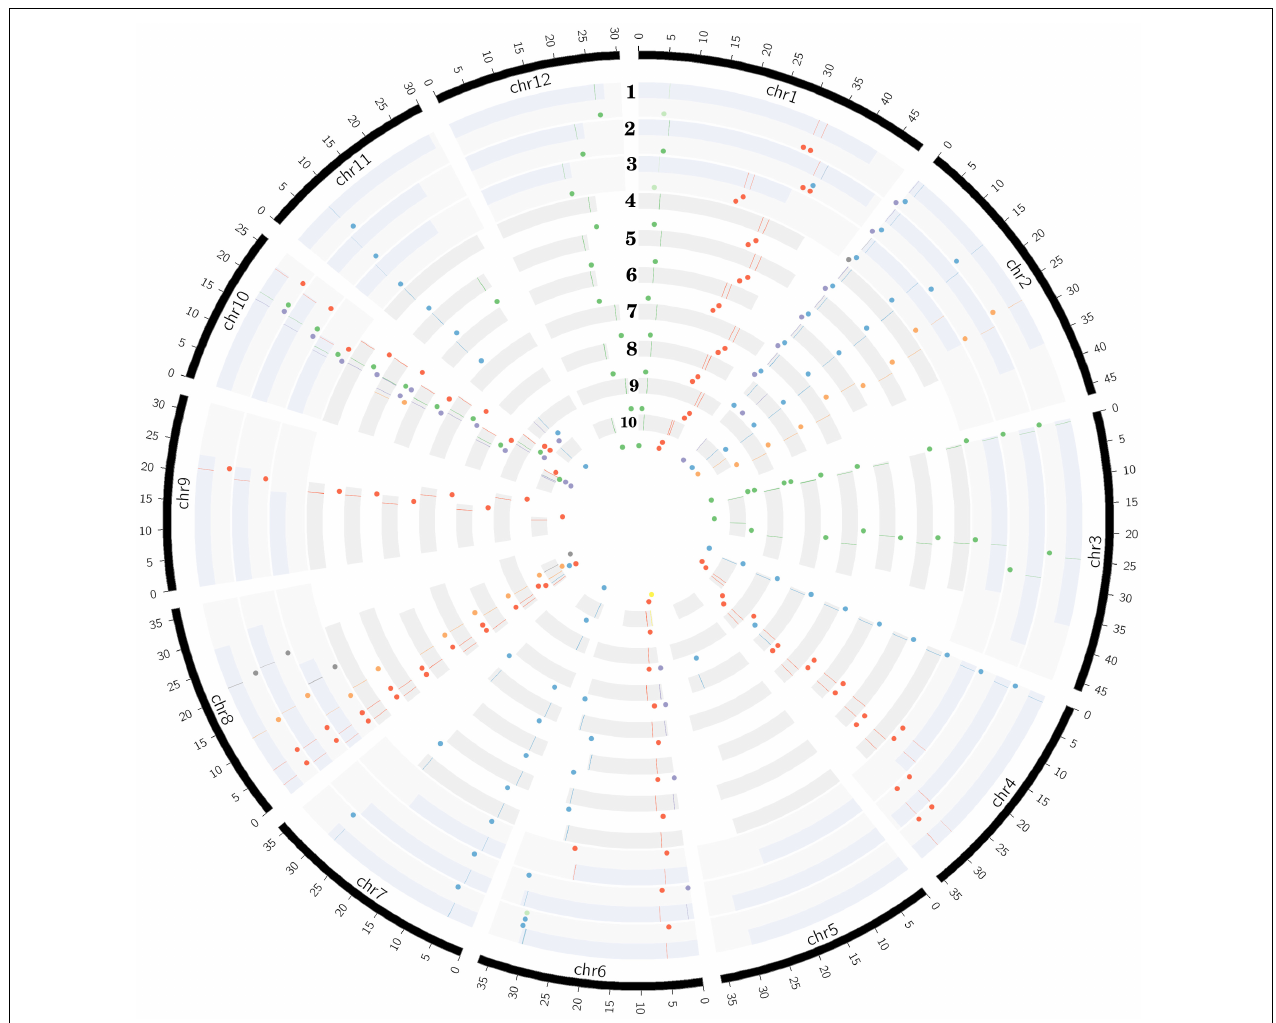
FIGURE 2 | Distribution of all eight START categories (colored dots shown internal to chromosomes in circular ribbons and lines on chromosomes) across 10 Oryza genomes (each ribbon representing a chromosome in circular form). The 10 rices are arranged in order of cultivated (1–3) and wild (4–10), and represented in evolutionary order from recently evolved to the oldest: 1- Oryza sativa var. japonica , 2- Oryza sativa var. indica, 3- Oryza glaberrima, 4- Oryza rufipogon, 5- Oryza nivara, 6 -Oryza barthii, 7- Oryza glumaepatula , 8- Oryza meridionalis , 9- Oryza punctate , and 10- Oryza brachyantha . START types represented by circular glyphs/dots: blue, Minimal START; gray, SD; very light green, SM; yellow, PS; purple, PSD; red, HS; light orange, HZS; and green,